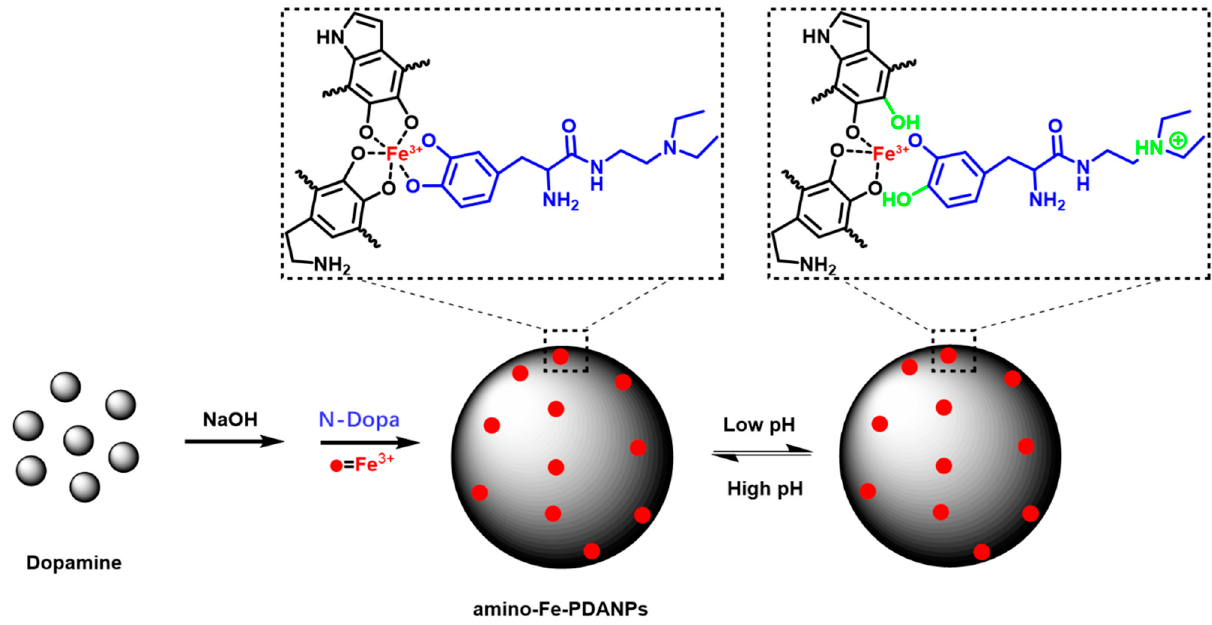
Figure 1. The synthetic process and pH-responsive properties of the amino-Fe-PDANP S .